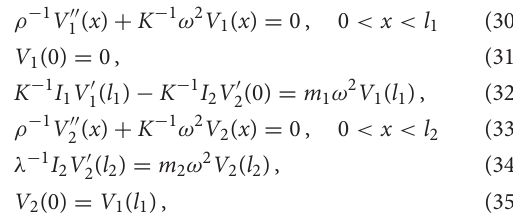
52.1107 and ω 2 54.0796 ∼ ∼ 51.4250 and ω ∗ 2 55.2638 for ∼ ∼